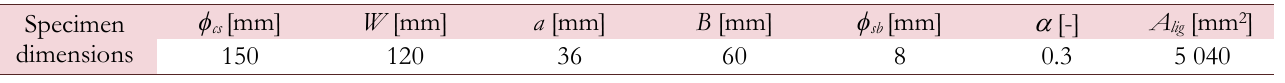
Table 1: Used dimensions of the MCT specimens in numerical